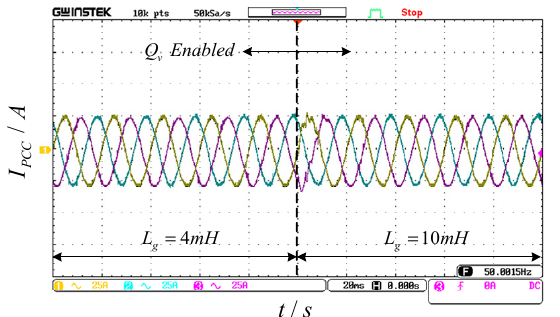
Figure 28. Experimental result of current waveform at PCC after reshaping when the grid-side